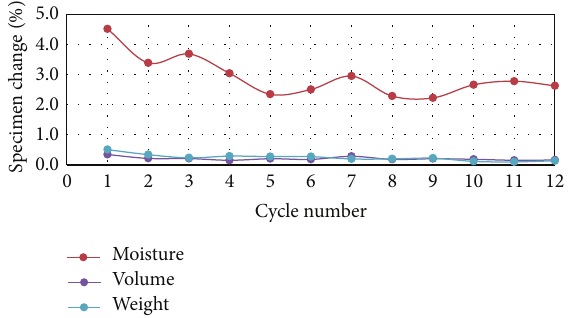
Figure 11: Moisture, volume, and weight changes of CBETB.